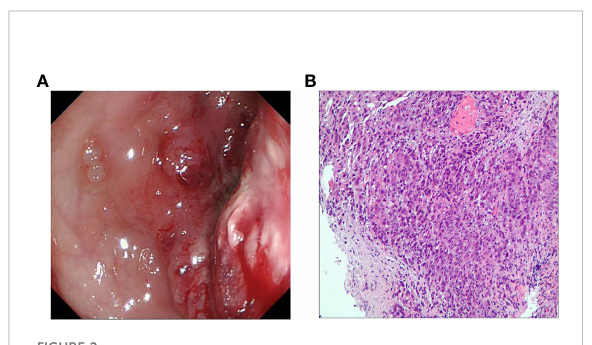
FIGURE 3 MRI review in March 2021 after neoadjuvant immunotherapy combined with chemotherapy showed a signi fi cantly smaller lesion than before (A) . MRI review in April 2021 showed a further smaller lesion than before with no signi fi cant thickening (B)